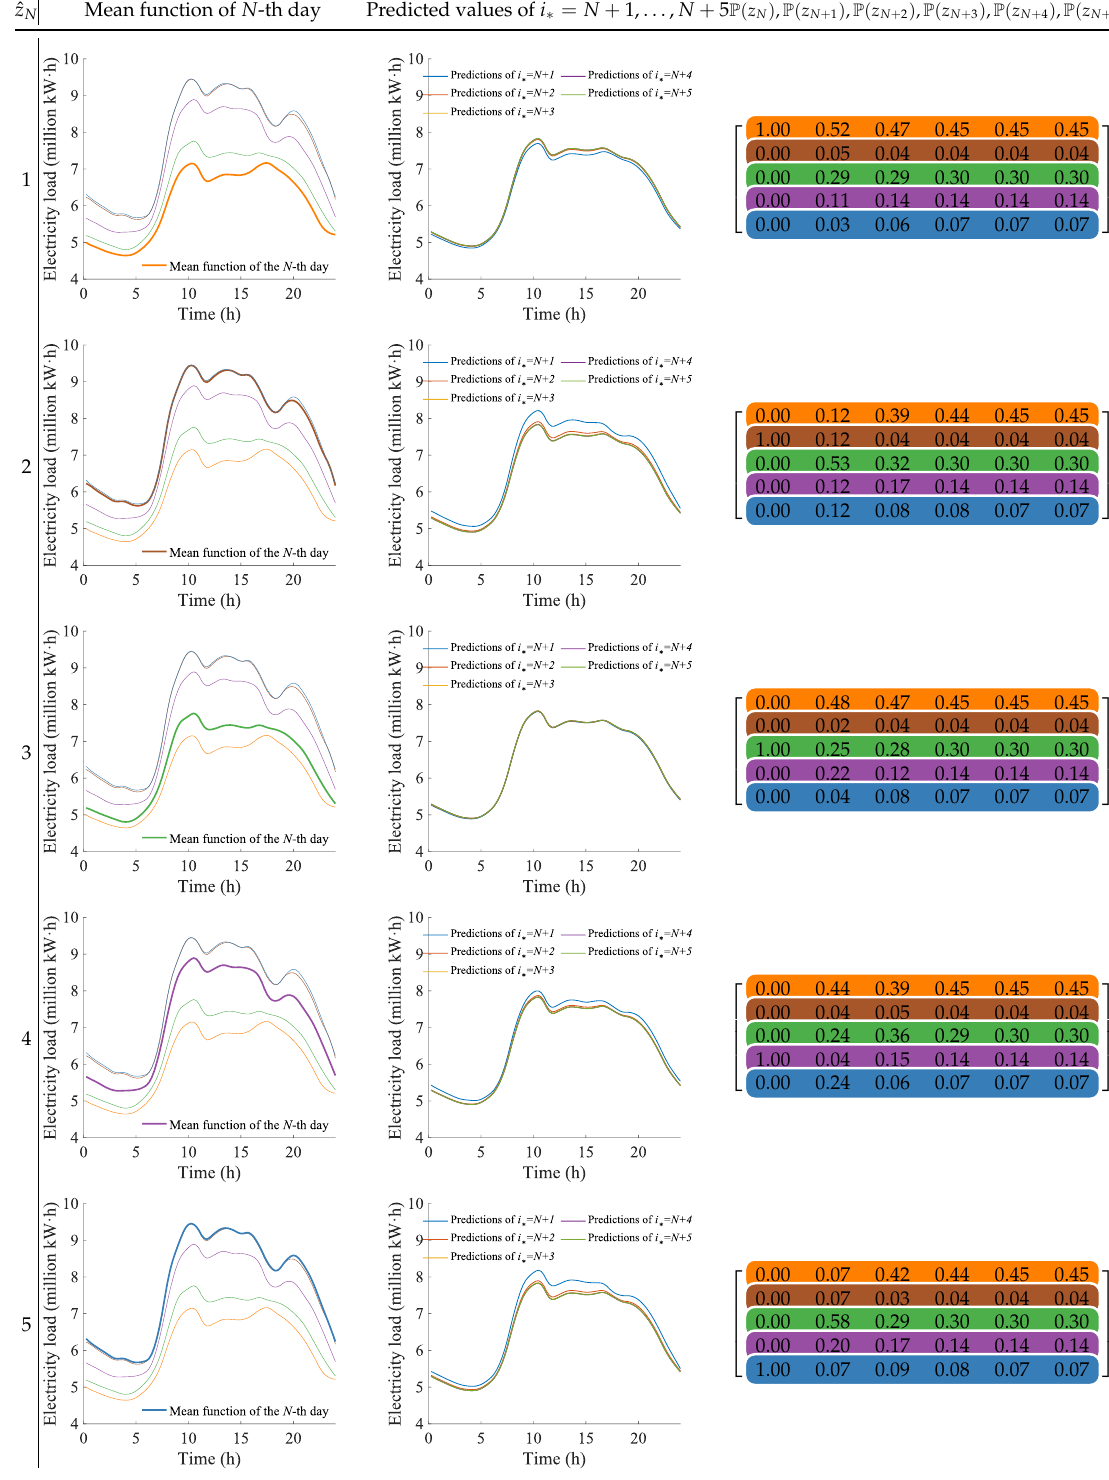
Figure 8. Estimated values ˆ y ˆ z = k , where k =